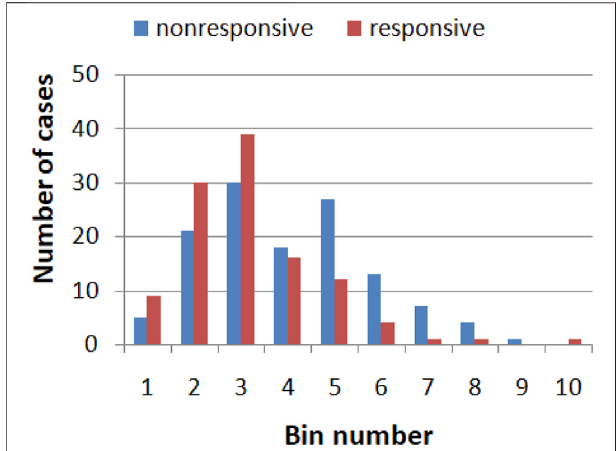
FIGURE 1 | The histogram showing correlation between the expression of the RPS7 gene and responsive (red)/nonresponsive (blue) results of drug therapy. The range of gene expression values corresponding to each bin are given in Table 2